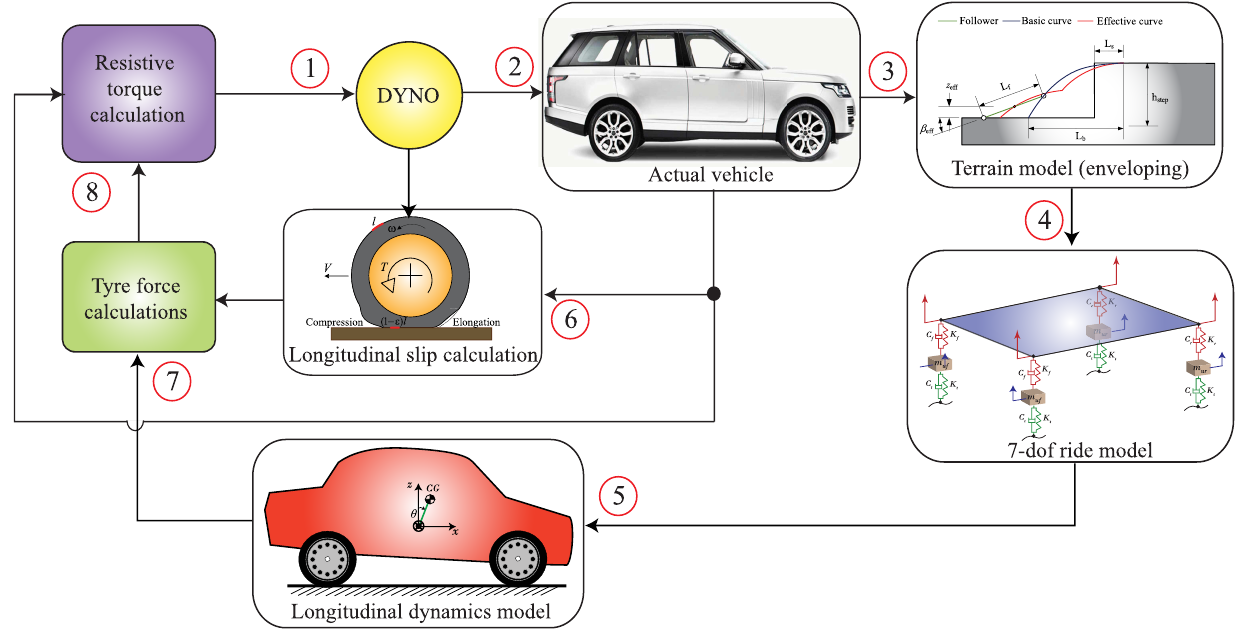
Fig. 1. Working principle of the ORES